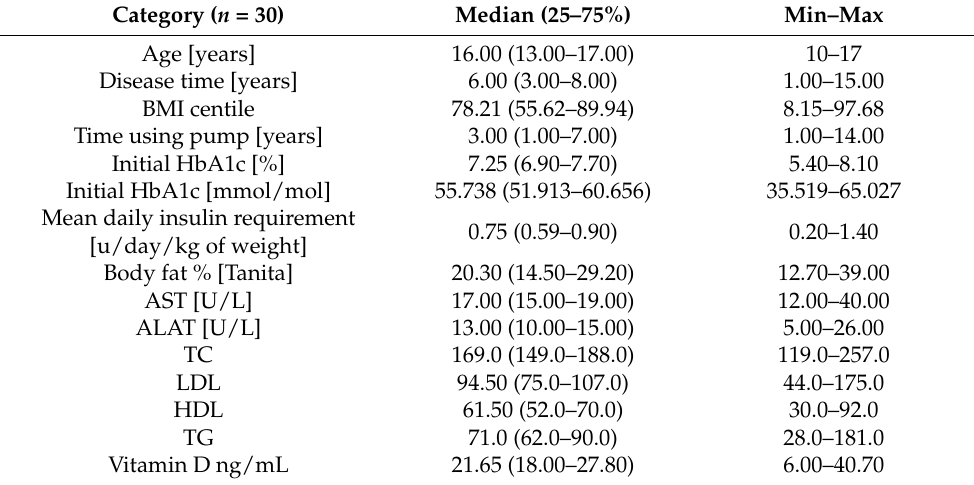
Table 1. Study group